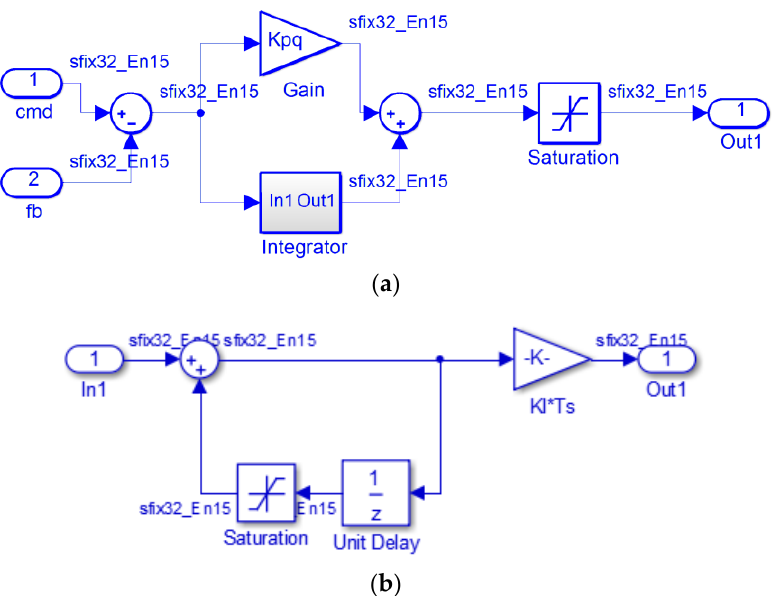
Figure 5. The resulting hardware digital control system.